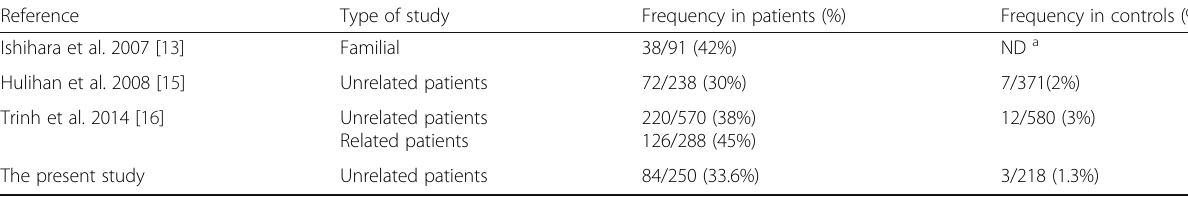
Table 3 Summary of previous screening studies of the G2019S mutation in the Tunisian population Reference Type of study Frequency in patients (%) Frequency in controls (%) Ishihara et al. 2007 [13]